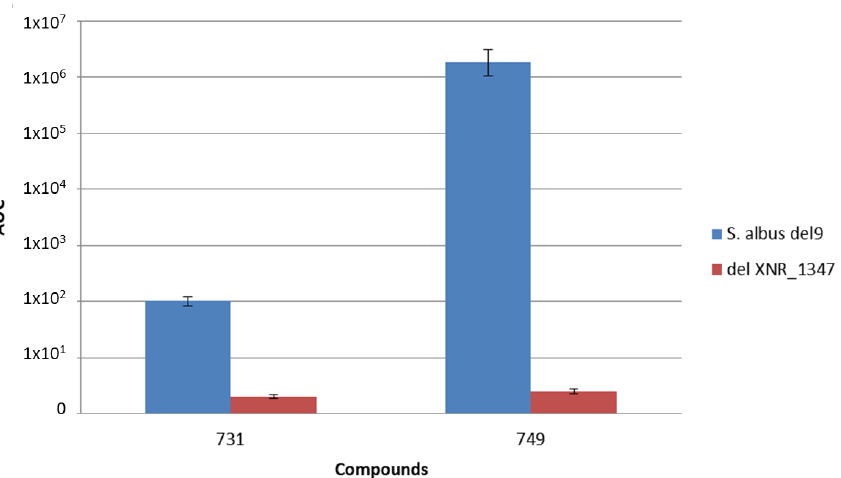
Figure 3. Faulknamycin production in the S. albus del9 and delXNR_1347 strains: 731–cyclofaulknamycin; 749–iso-faulknamycin.